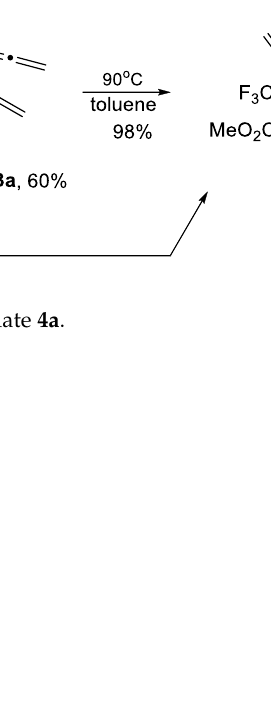
Figure 2. Structure of proline 4a (CCDC 2208592).